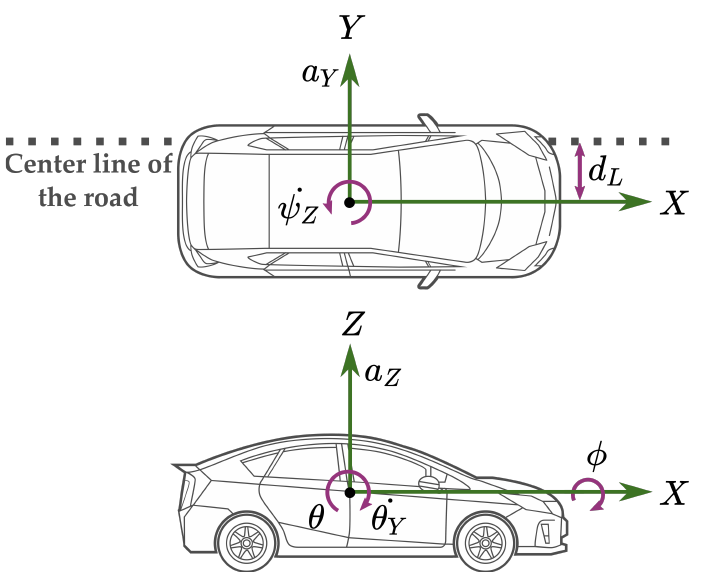
Figure 5. Illustration of the selected input feature variables on side and top views of the